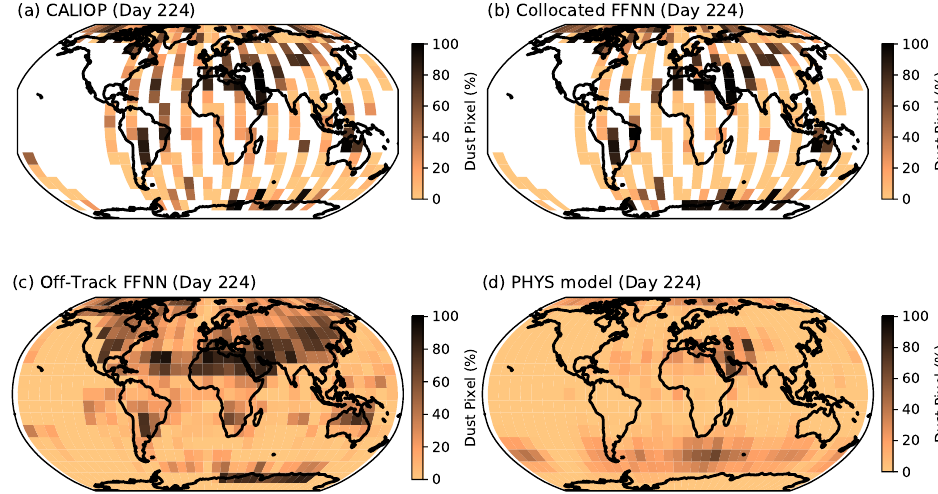
Figure 8. Dust distribution of day 224 for ( a ) on-track CALIOP product, ( b ) on-track FFNN prediction, ( c ) off-track FFNN, and ( d ) off-track PHYS. Missing observations where there are no CALIOP overpasses are marked as